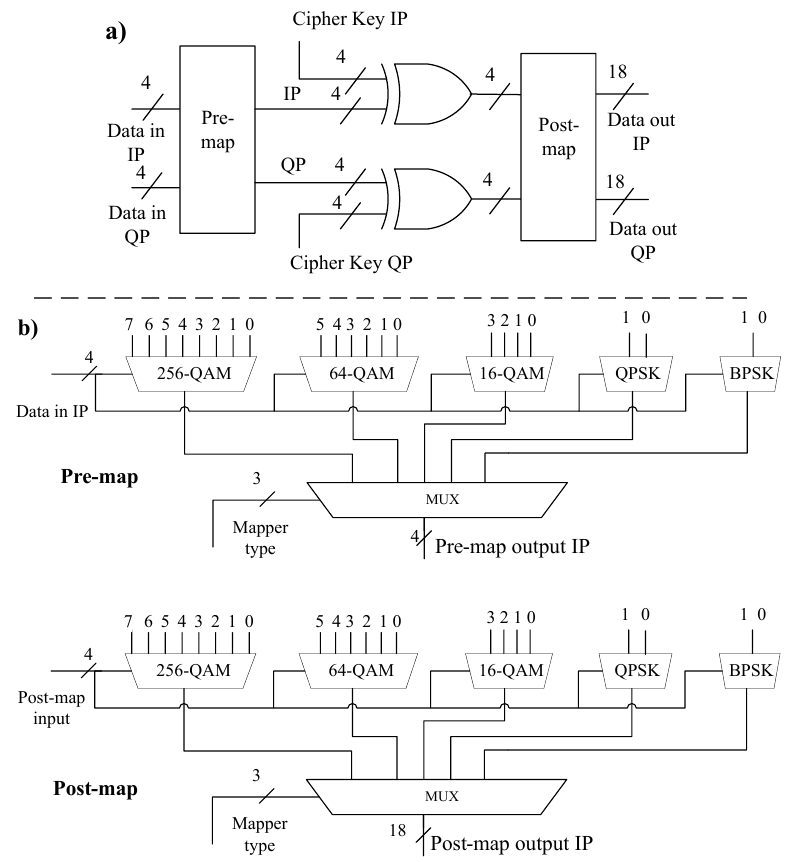
Figure 6. ( a ) Hardware architecture of the JEM encryption; ( b ) the pre-map and post-map